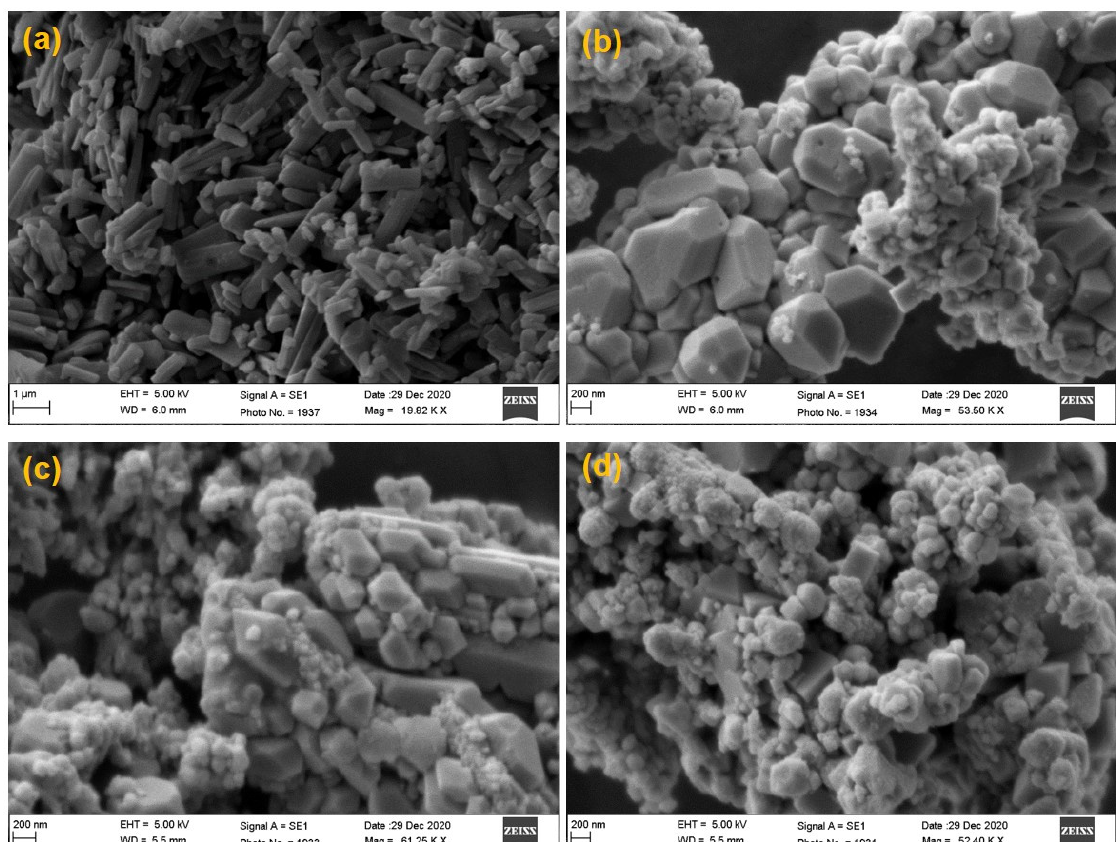
Figure 3. SEM images of pure tedizolid phosphate powder ( a ); and TZP-NCs prepared at varying duration of homogenization and probe sonication, respectively: 5 min and 40 s ( b ); 7.5 min and 50 s ( c ); 10 min and 60 s ( d ).